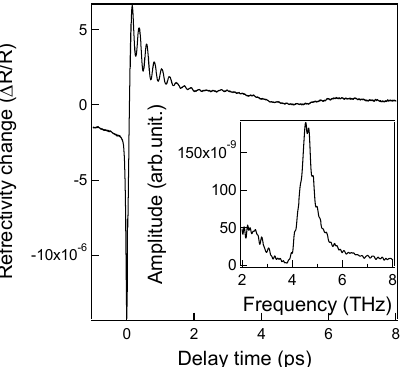
Fig. F = 18 μJ/cm 2 and 12 K. The Fourier spectrum of